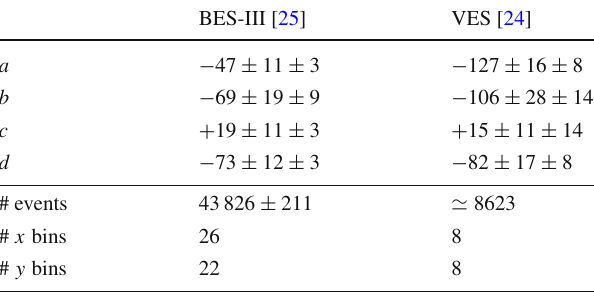
Table 1 Dalitz-plot parameter measurements by the BES-III and VES collaborations in units of 10 − 3 . The first error on the Dalitz-plot param- eters is always statistical, the second systematic. We have estimated the number of η (cid:2) → ηπ + π − events for the VES collaboration from the total number of η (cid:2) events and the branching ratio B (η (cid:2) → ηπ + π − ) = (